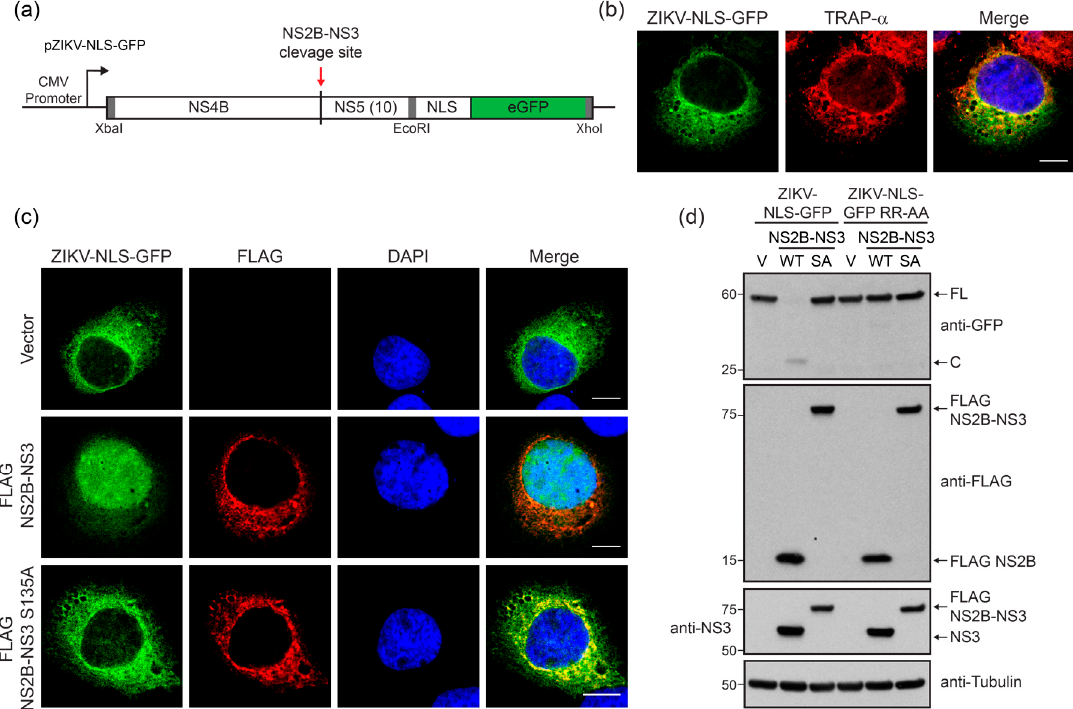
Figure 1. A cleavable reporter to measure Zika virus (ZIKV) non-structural proteins 2B and 3 (NS2B-NS3) protease cleavage. ( a ) Schematic of the fluorescent ZIKV-nuclear localization signal (NLS)-GFP reporter plasmid (pZIKV-NLS-GFP) construct encoding ZIKV non-structural protein 4B (NS4B) (aa2270–2520) and the first 10 amino acids of non-structural protein 5 (NS5) (aa2521–2530), fused in frame to a nuclear localization signal (NLS) and enhanced green fluorescent protein (eGFP). The red arrow indicates the NS2B-NS3 protease cleavage site. Restriction sites used for cloning are indicated by gray boxes. ( b ) Confocal micrographs of Huh7 cells expressing ZIKV-NLS-GFP (green) and immunostained with the endoplasmic reticulum (ER) marker translocon-associated protein, alpha subunit (TRAP- α ) (red). Nuclei were stained with DAPI (4 ′ ,6-diamidino-2-phenylindole) (blue). Scale bar, 10 μ m. ( c ) Confocal micrographs of Huh7 cells expressing ZIKV-NLS-GFP (green) and either FLAG-tagged-NS2B-NS3, WT or S135A, or vector, that were immunostained with anti-FLAG (red). Nuclei were stained with DAPI (blue). Scale bar, 10 μ m. ( d ) Immunoblot analysis of extracts from Huh7 cells expressing either WT ZIKV-NLS-GFP or a non-cleavable ZIKV-NLS-GFP RR-AA reporter, and also either wild-type (WT) or S135A (SA) FLAG-tagged ZIKV NS2B-NS3, or vector (V). Arrows mark full-length (FL) or cleaved (C) ZIKV-NLS-GFP.